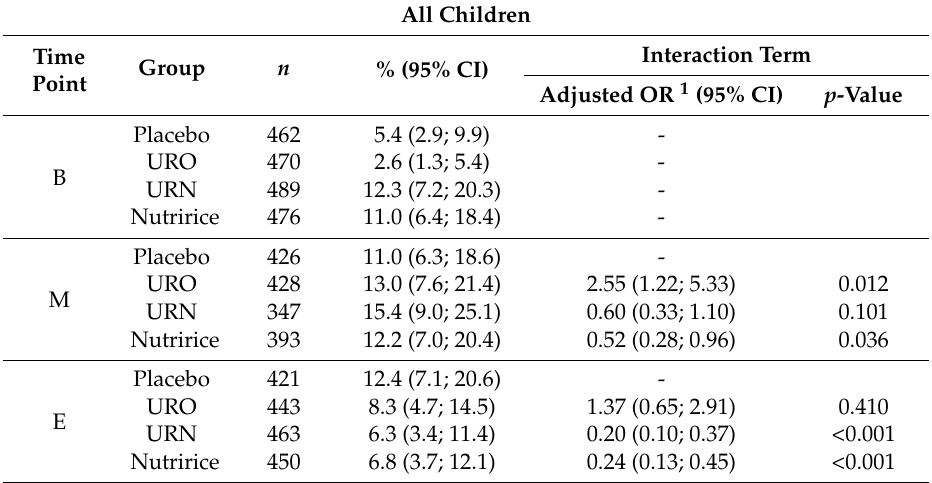
Table 6. Prevalence of marginal VA status after three and six months of intervention among all children. All